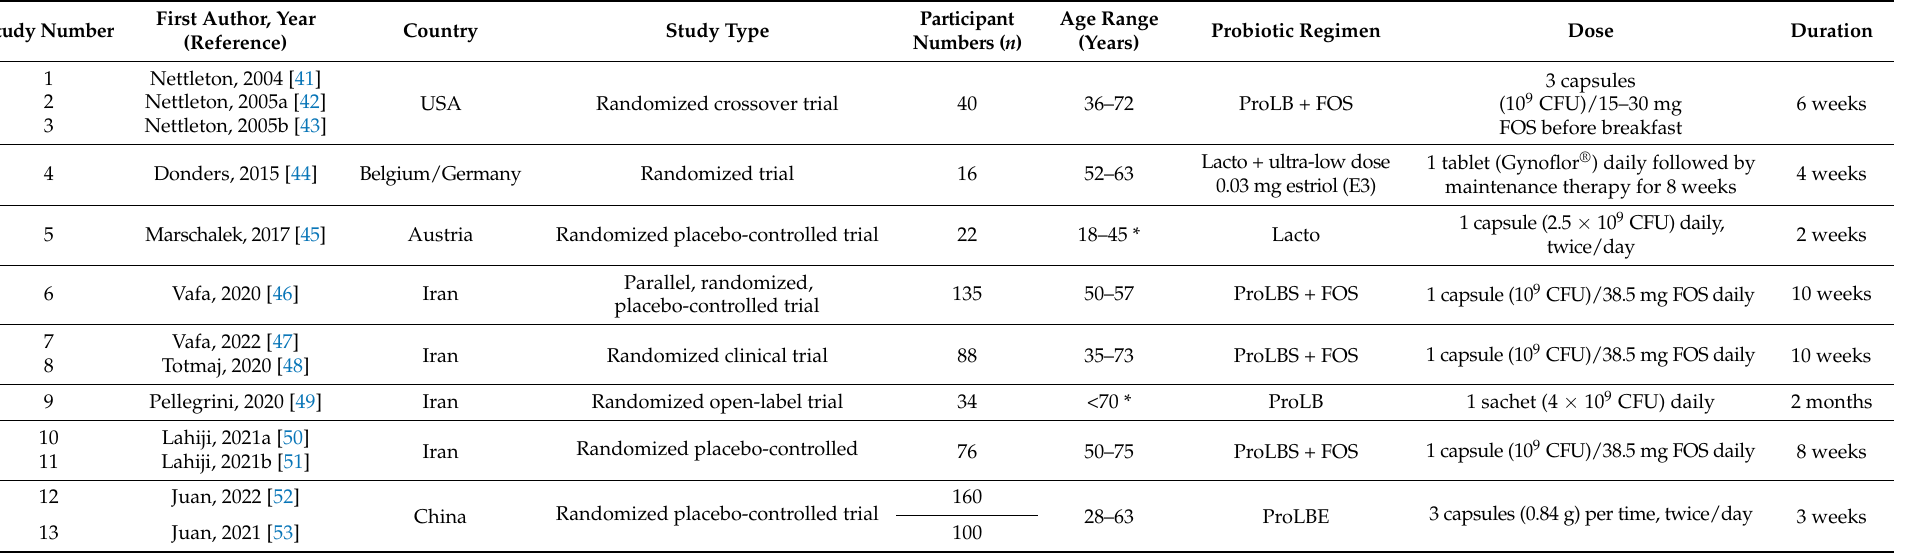
Table 1. Baseline characteristics within the identified